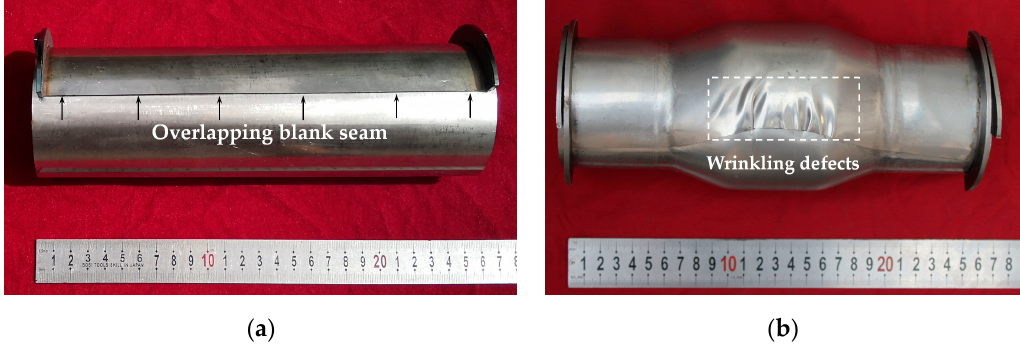
Figure 13. Hydroforming of overlapping blank under axial constraints in experiment results. ( a ) Initial blank; ( b ) hydroformed part.